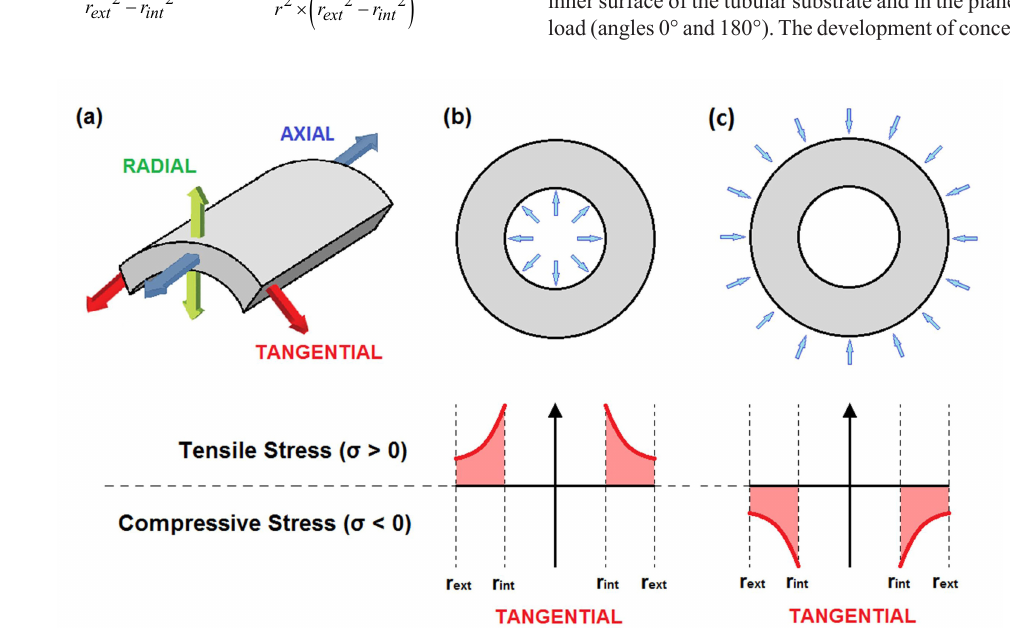
Figure 3. (a) The three types of stresses existing in a tube; and the profile of the tangential stresses along the thickness of a tube under a homogeneous: (b) internal pressure and (c) external pressure, according to Lamé’s equation 21